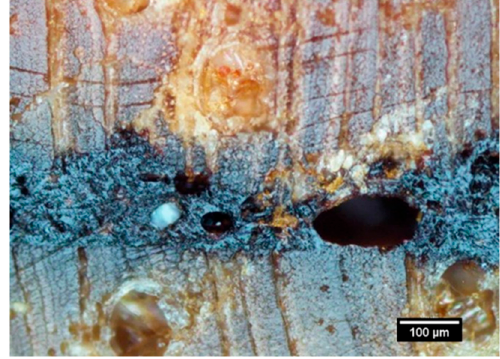
Figure 5. Voids in RF adhesive in spotted gum glulam [7].